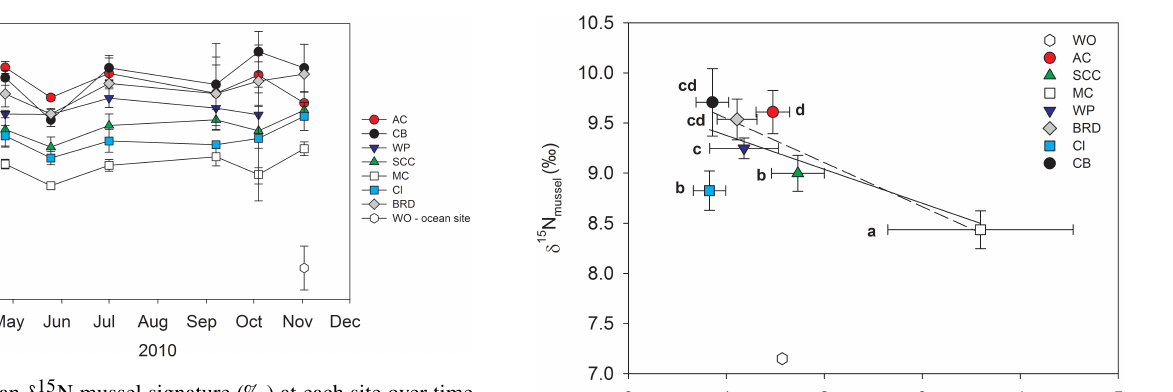
Figure 5. Mean δ 15 N mussel signature (‰) at each site over time. Error bars represent standard deviations of N = 3 for April–July and WO, and N = 2 for September–November 2010.